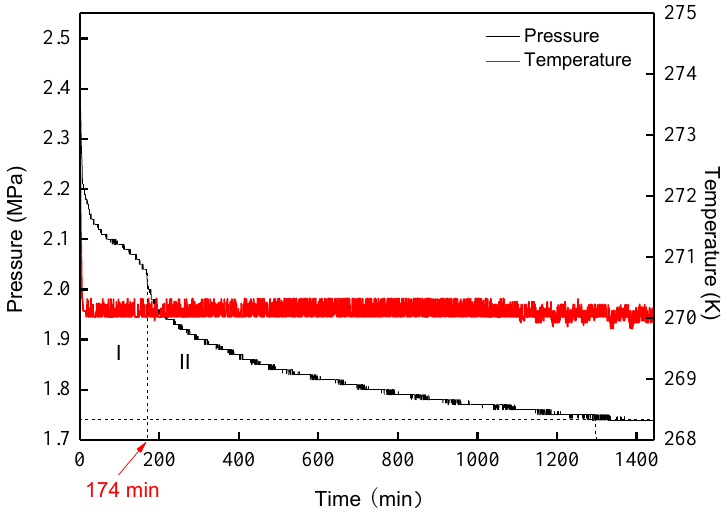
Figure 2. The CP-CO 2 system pressure and temperature curves at 2.5 MPa.